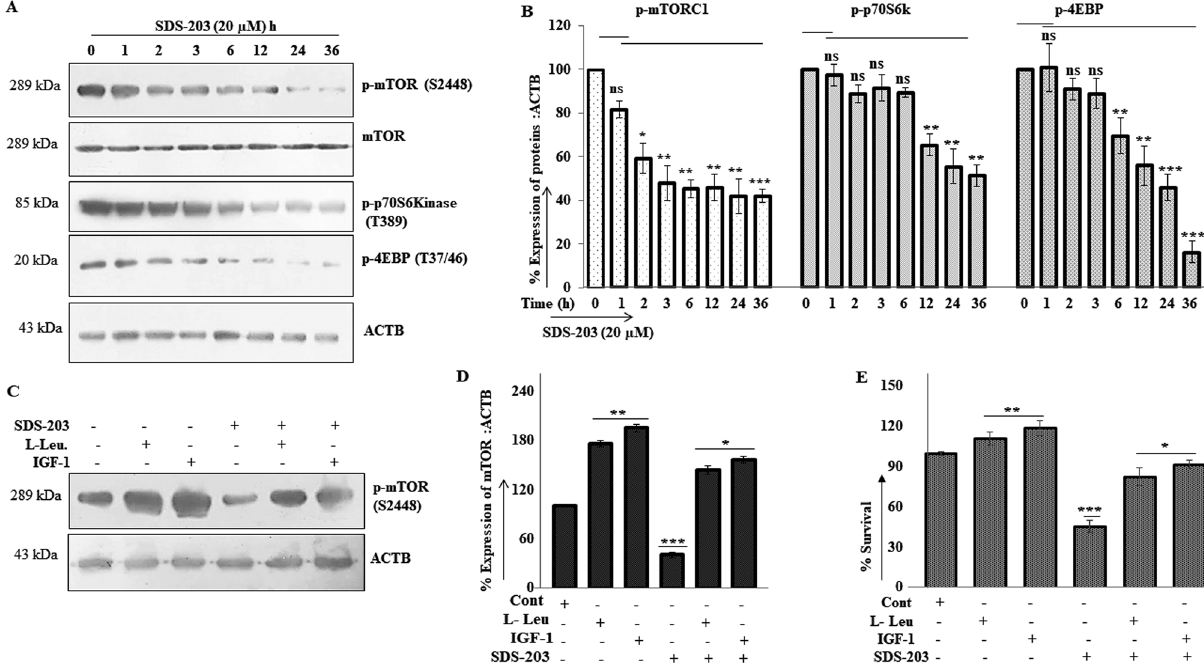
Figure 3. SDS-203 induces autophagy by inhibiting mTORC1 activity. ( A , B ) MIA PaCa-2 cells were treated with SDS-203 (20 μM) for various time points (0, 1, 2, 3, 6, 12, 24, 36 h) and its effect on p-mTORC1 along with its downstream target s– p-p70S6kinase and p-4EBP1, were analyzed and quantified. ( C , D ) MIA PaCa-2 cells were incubated with SDS-203 (20 µM) for 24 h in the presence or absence of IGF-1 (50 ng) or l-leucine (0.5 mM). Protein expression was analyzed and quantified by using ImageJ software. ( E ) Graphical representation (MTT) of survival percentage of MIA PaCa-2 cells treated with SDS-203 (20 µM) for 48 h in presence or absence of l-leucine (0.5 mM) or IGF-1 (50 ng). All data are presented as the mean of SD from three independent experiments. Statistics, Student’s t test *p < 0.05, ** p < 0.01, *** p <0.001 vs. control (0.1%